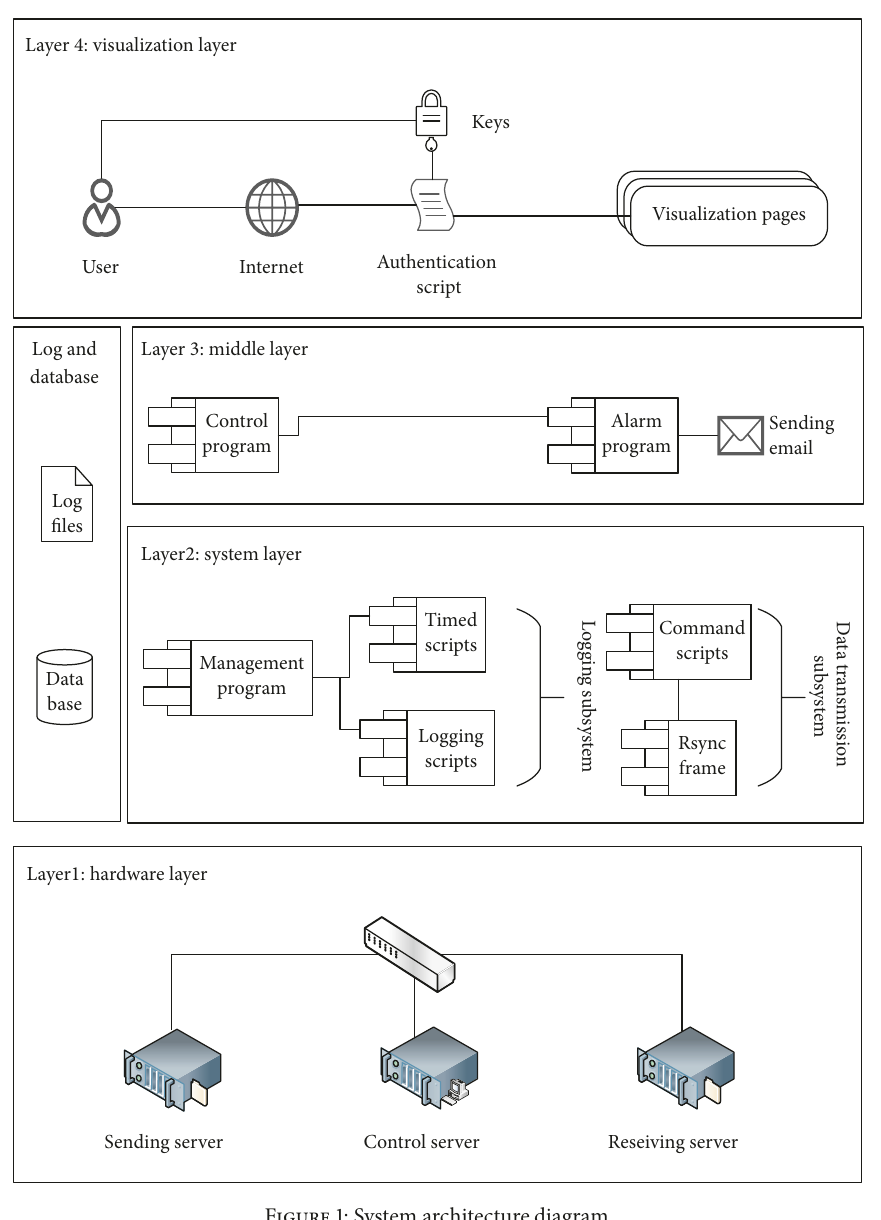
Figure 1: System architecture diagram.